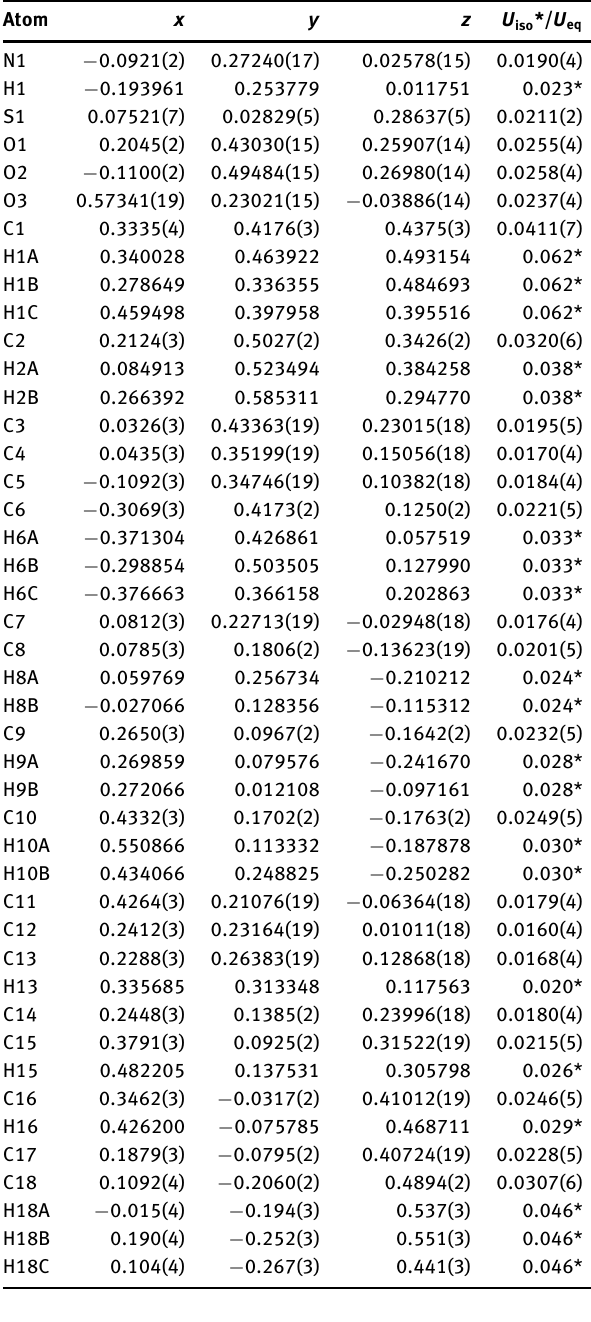
Table 2: Fractional atomic coordinates and isotropic or equivalent isotropic displacement parameters (Å 2